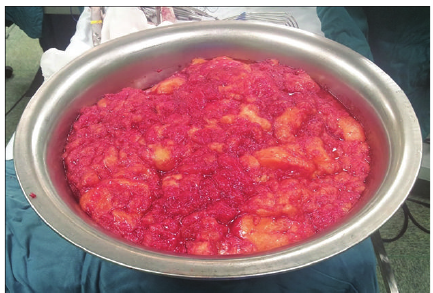
Figure 3: Intraoperative view of a very large tumor placed in a large container.